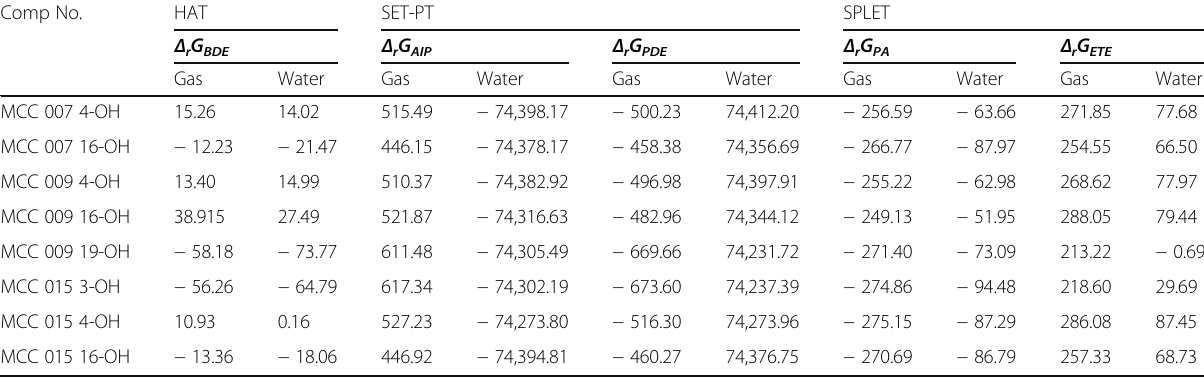
Table 3 Gibbs free energy changes ( Δ r G in kJ/mol) of scavenging HOO· radical by curcumin derivatives at the B3LYP/6-311G*/6-31G* level in vacuum and water Comp